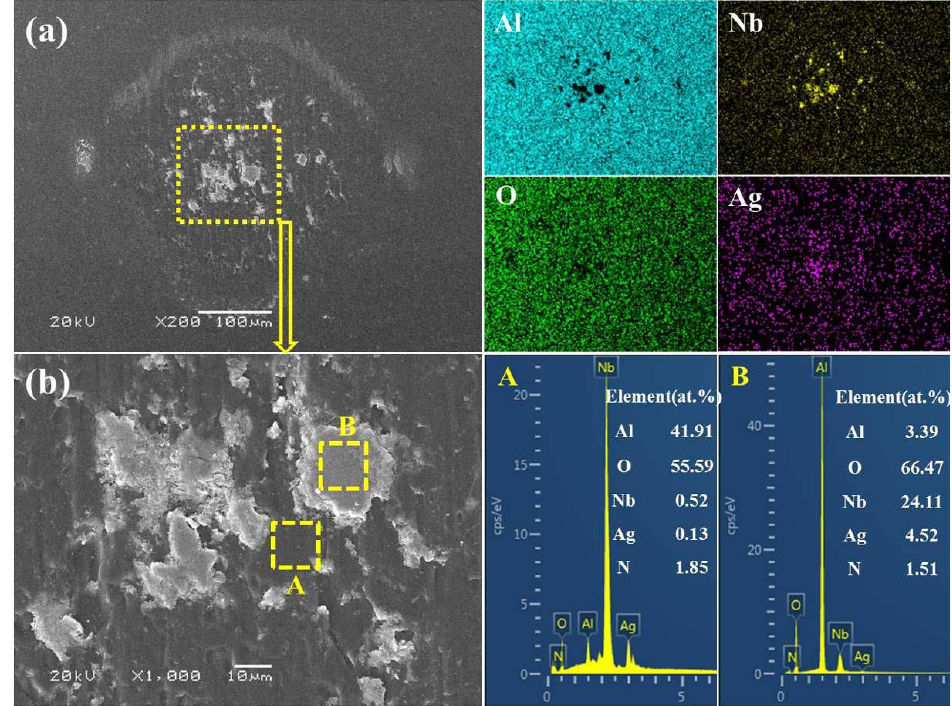
Figure 10. Wear scar for Al 2 O 3 ball after sliding against NbN/NbN-Ag film ( a ) and its magnified image ( b ), as well as corresponding EDS maps of ( a ) and the EDS spectra for selected regions A and B in ( b ).